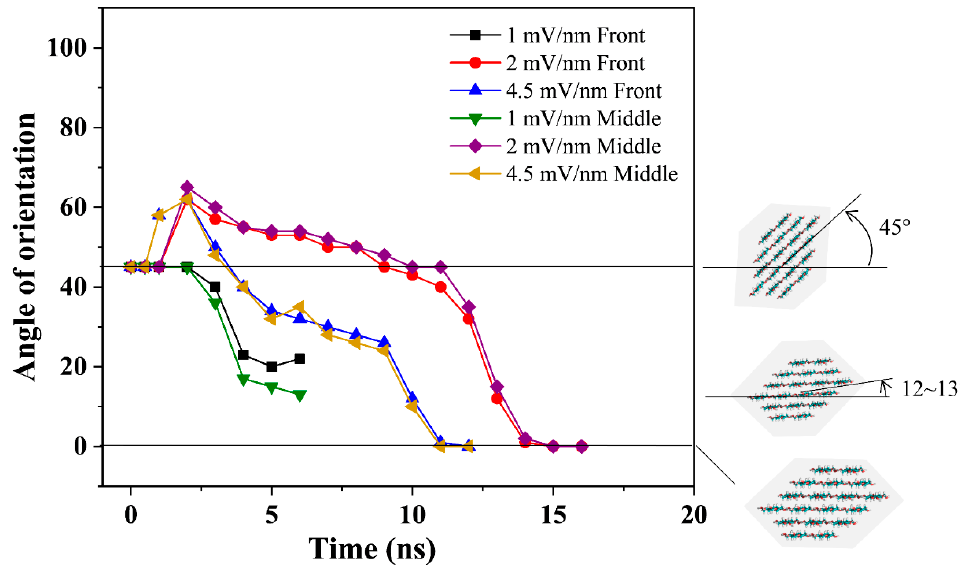
Figure 7. The orientation angles of the front and middle cross-sections of the CNF model to the x-axis throughout the simulation time for all the applied electric field strengths.